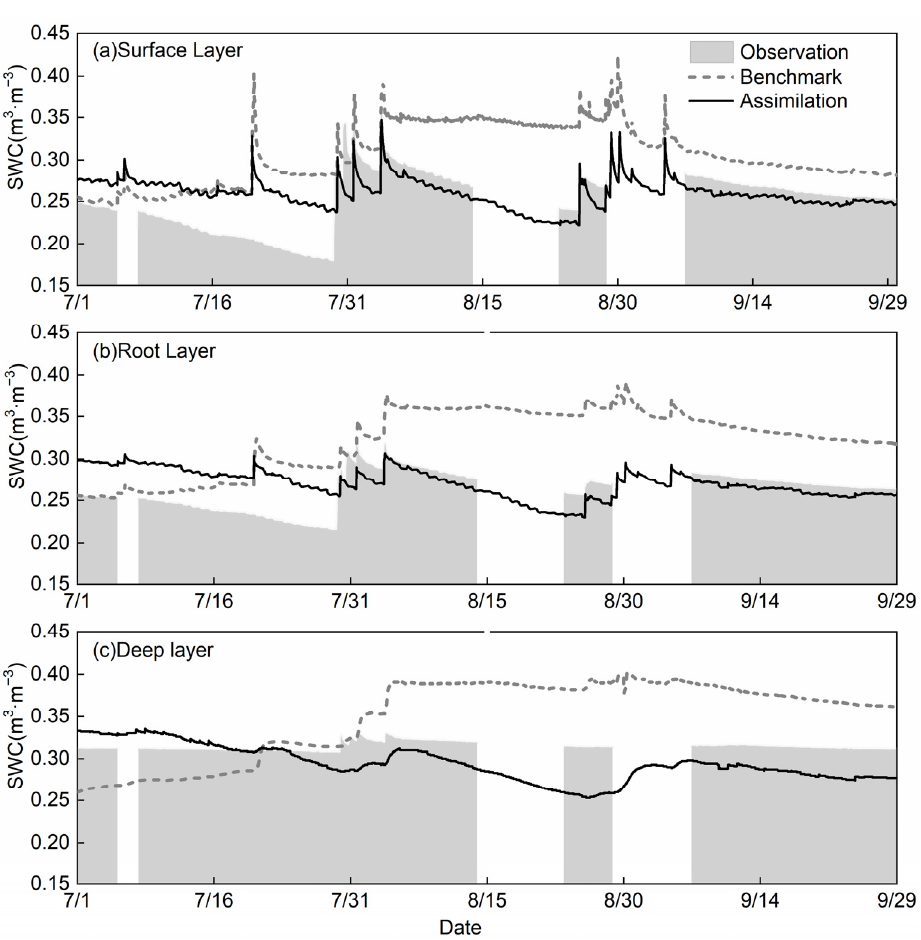
Figure 6. Simulation and observation of SWC in three layers in maize season.